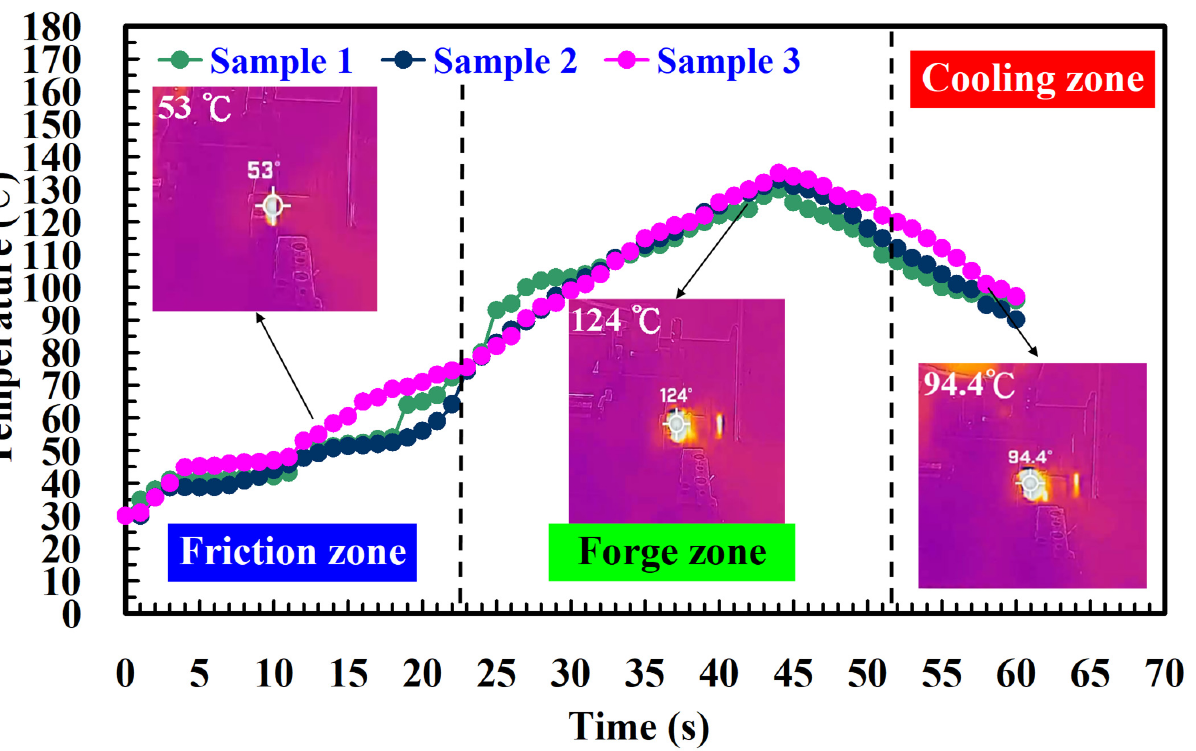
Figure 6. The relationship between weld-joint temperature and FW time for PLA and PLA rods at a rotational speed of 1350 rpm.